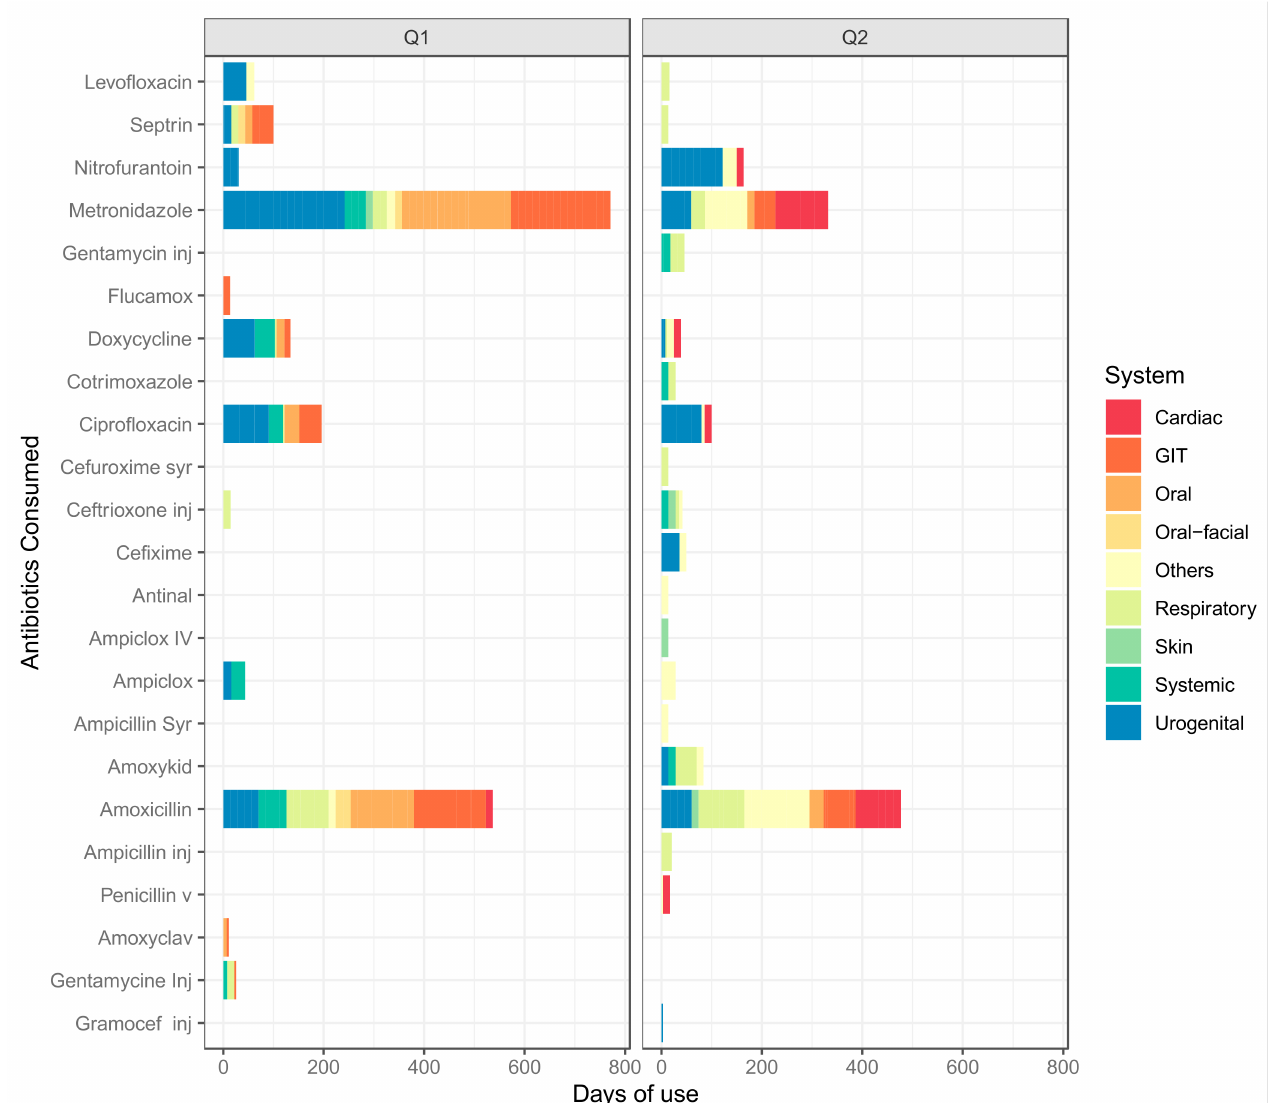
Figure 10. Antibiotic prescription at the outpatient department of Arua regional referral hospital for Quarter 1& Quarter 2 of 2019. The figure is a bar plot whose axes were flipped to improve visualisation. The y -axis shows the cumulative number of days the patients at this department were on any given antibiotics while the x -axis shows the type of antibiotics. The color fill shows the system to which the disease under management clusters. For example, a Urinary tract infections would cluster under Urogenital system. Note that majority of the “others” are malaria